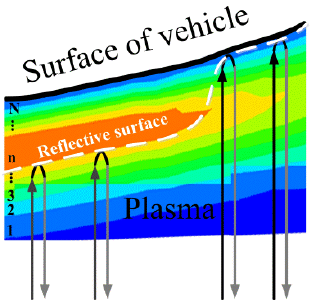
Figure 9. Reflective surface of EM wave in plasma.